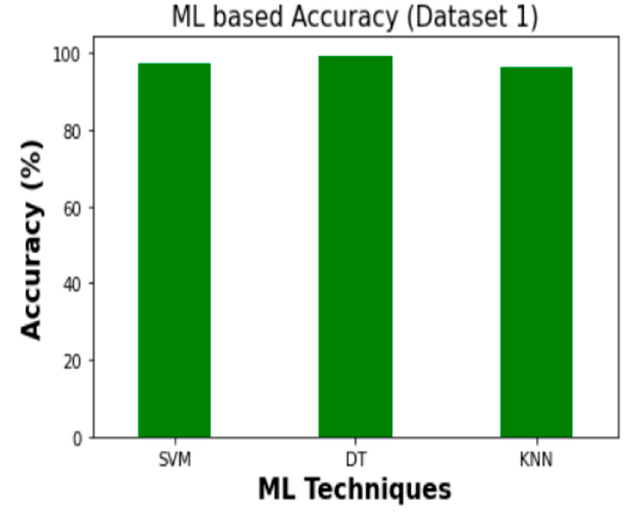
Figure 15. Accuracy comparison (Dataset 2).